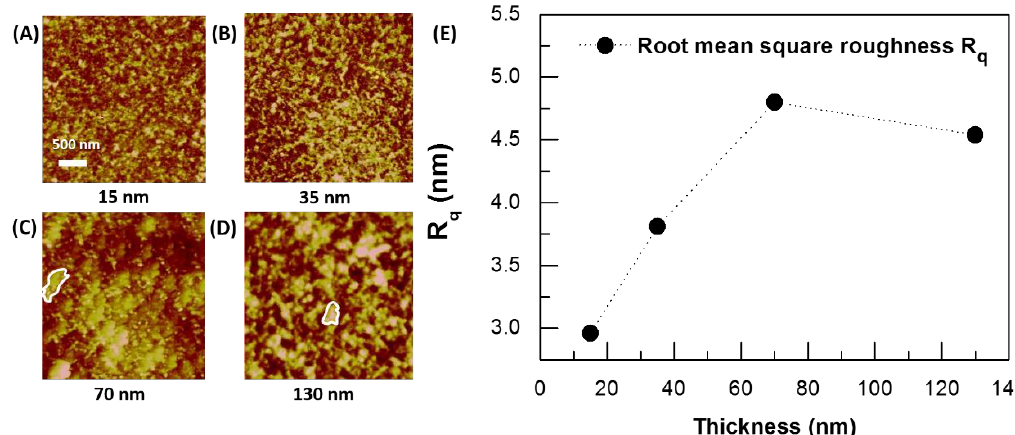
Figure 5. AFM micrographs for ( A ) 15-, ( B ) 35-, ( C ) 70-, and ( D ) 130-nm-thick PEDOT:PSS films (scale bar 500 nm; white circles indicate typical PEDOT domains); ( E ) saturated root mean square roughness ( R q ) as a function of the device channel thickness.